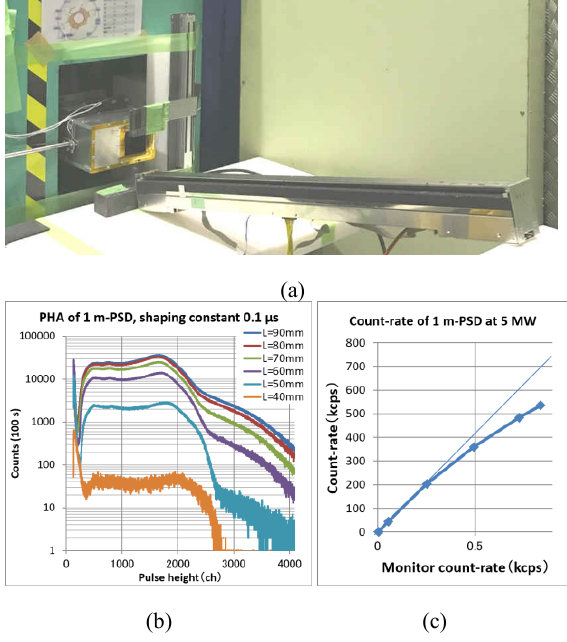
Fig. 10. (a) Oblique placement of the PSD on the beam. (b) Pulse height distribution. (c) Count rate.